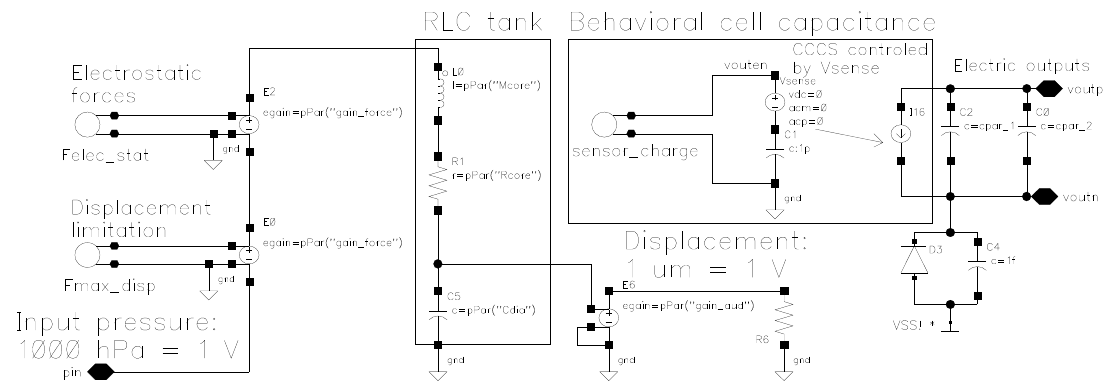
Figure 4. SPICE model of one single MEMS pressure sensor